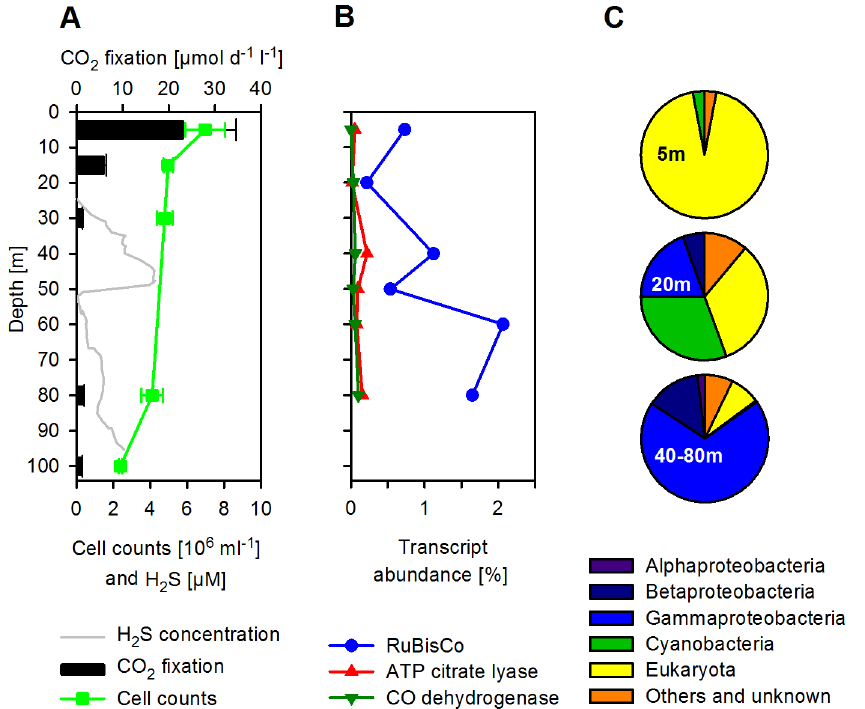
Figure 8. Vertical distribution of CO2 fixation rates, microbial cell counts and abundance of transcript encoding for key carbon- fixing enzymes. (A) CO 2 fixation rates and total microbial cell counts. (B) Abundances of transcripts encoding for carbon-fixing enzymes (in percent of all protein-coding RNA sequences): Ribulose-1,5-bisphosphate carboxylase oxygenase (RuBisCo, EC 4.1.1.39, Calvin-Benson-Bassham cycle), ATP citrate lyase (EC 2.3.3.8, Arnon-Buchanan cycle) and CO-dehydrogenase (EC 1.2.99.2, Wood-Ljungdahl pathway). (C) Phylogenetic affiliation of the transcripts encoding for RuBisCo.